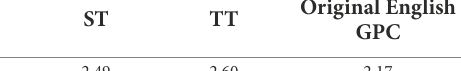
TABLE 8 Categories of how modal verbs were interpreted into English.